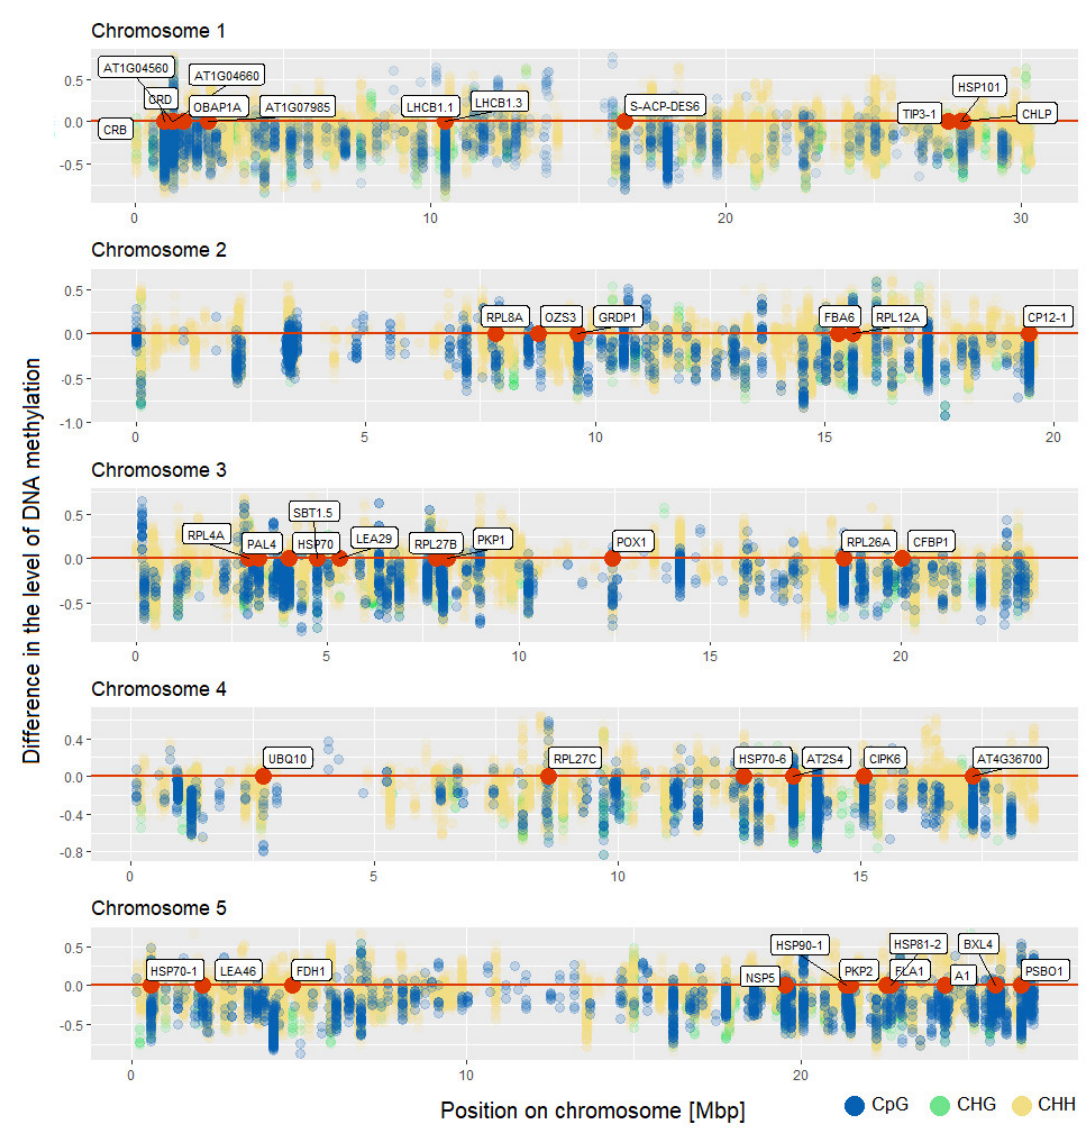
Figure 3. Number of differentially methylated Arabidopsis thaliana genes in different sequence con- texts.